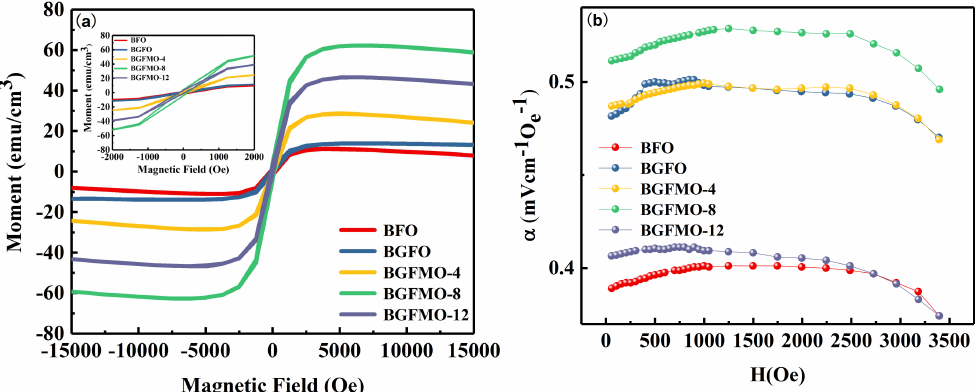
Figure 4. ( a ) The magnetic hysteresis loops of BFO, BGFO, BGFMO-4, BGFMO-8, and BGFMO-12 thin films. ( b ) The magnetoelectric coupling coefficients of these